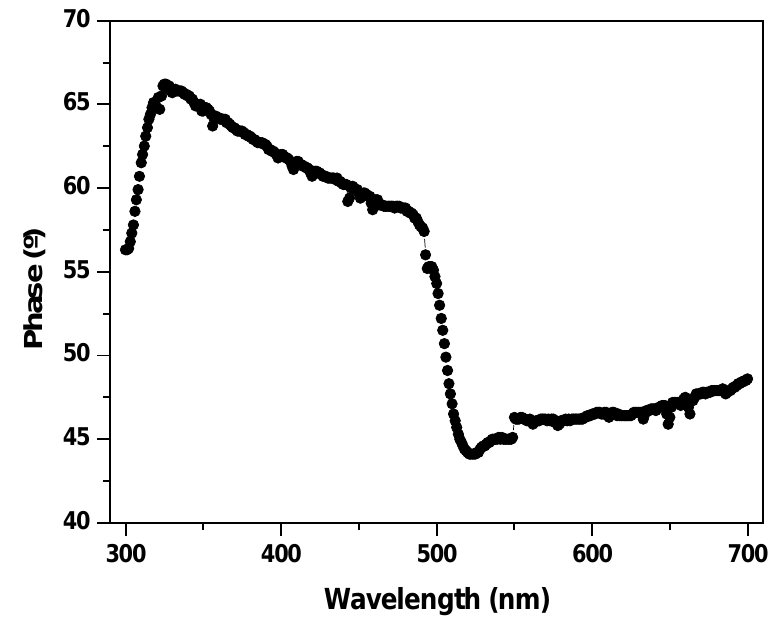
Figure 8. Phase of the reference signal obtained with the LDR. It can be observed a drop in the phase of approximately 15° at about 500 nm. This drop is related to the energy band gap of the semiconductor on the top of the